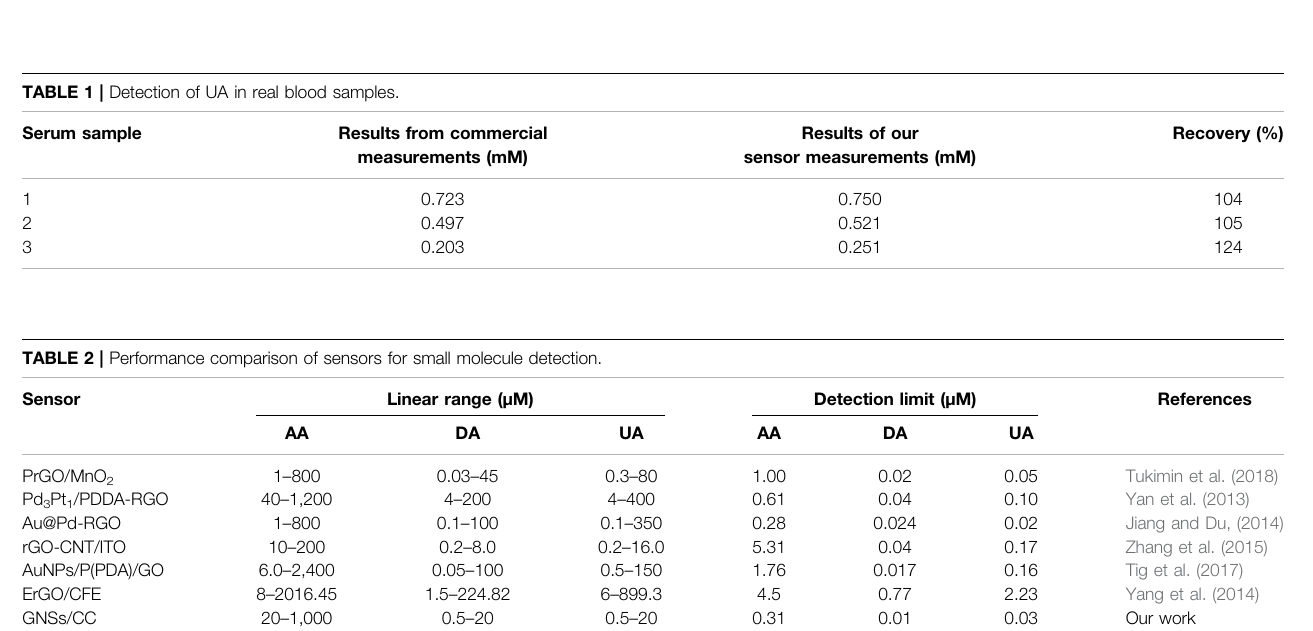
FIGURE6| 7 hGNSs/CCelectrodesareusedtodetectAA,DA,andUAbyDPVsimultaneously. (A) PulsedVolt – AmperecharacteristiccurvesofAA,DA,andUA. (B) The fi tting curve of peak current and concentration of AA. (C) The fi tting curve of peak current and concentration of DA. (D) The fi tting curve of peak current and concentration of